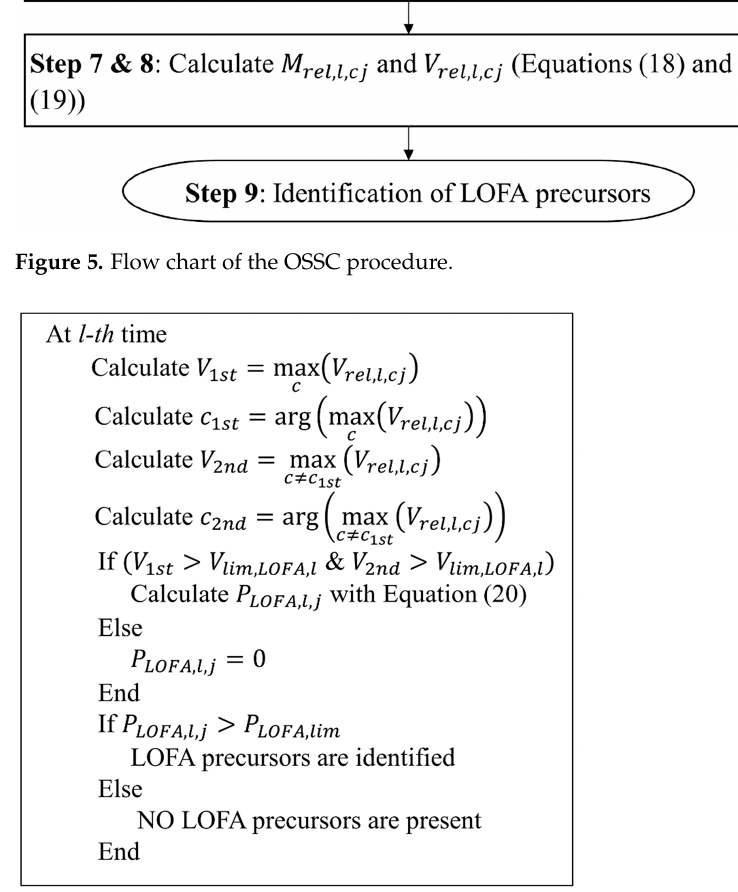
Figure 6. Pseudo code for (cid:1842) (cid:3013)(cid:3016)(cid:3007)(cid:3002),(cid:3039),(cid:3037) analysis.